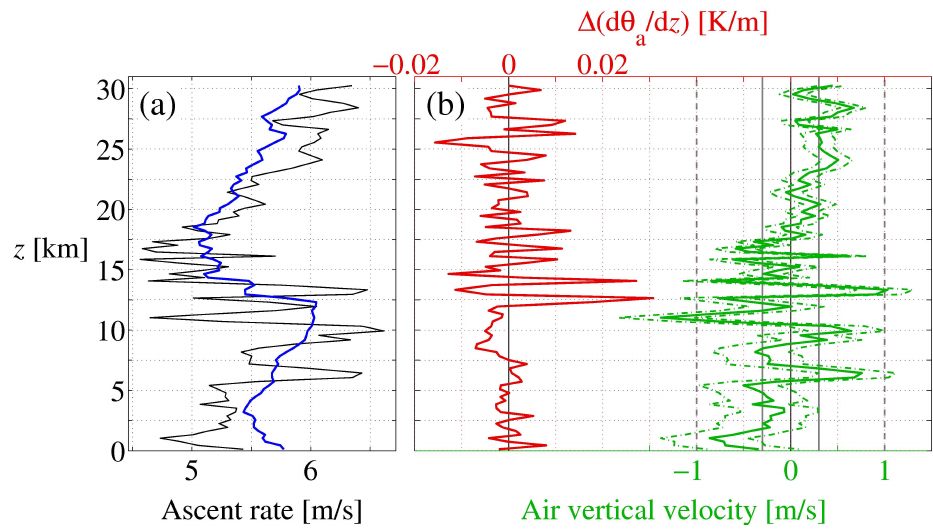
Fig. 8. Air vertical velocity during LUAMI flight L003a launched on 5 November 2008 at 22:45UTC. (a) Balloon ascent rate in still air as calculated from the model (—); actual balloon ascent rate derived from the GPS data (—). (b) Air vertical velocity obtained by subtracting the ascent rate in still air from the actual ascent rate (—), and the upper and lower limits of its associated range of uncertainty (– · – · –); deviations of the potential temperature lapse rate from its still air value, derived from the atmospheric temperature recorded during the balloon ascent (—). The vertical velocities derived by Hoyle et al. (2005) from aircraft measurements are indicated here as thin gray lines for comparison: typical gravity-wave fluctuations, ± 0 . 3ms − 1 (—); strong fluctuations representing less than ∼ 2% of all wave occurrences, ± 1ms − 1